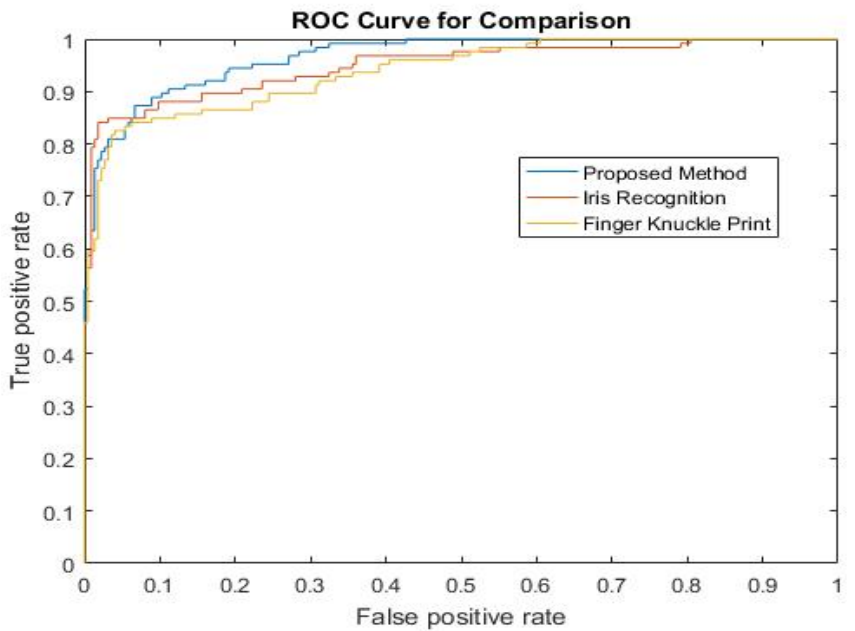
Figure 14. ROC curve for proposed method.